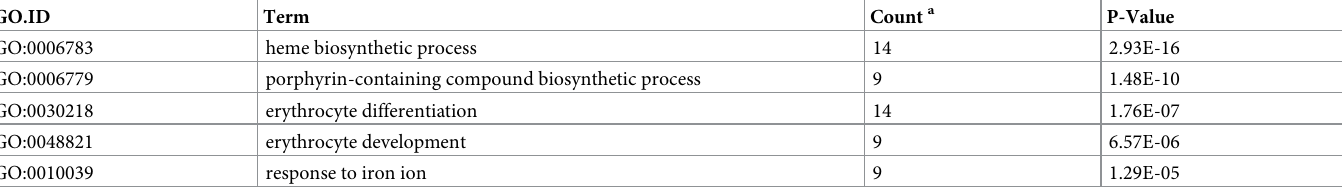
Table 1. Categories related to RBC function that are significantly downregulated by cocaine. GO.ID